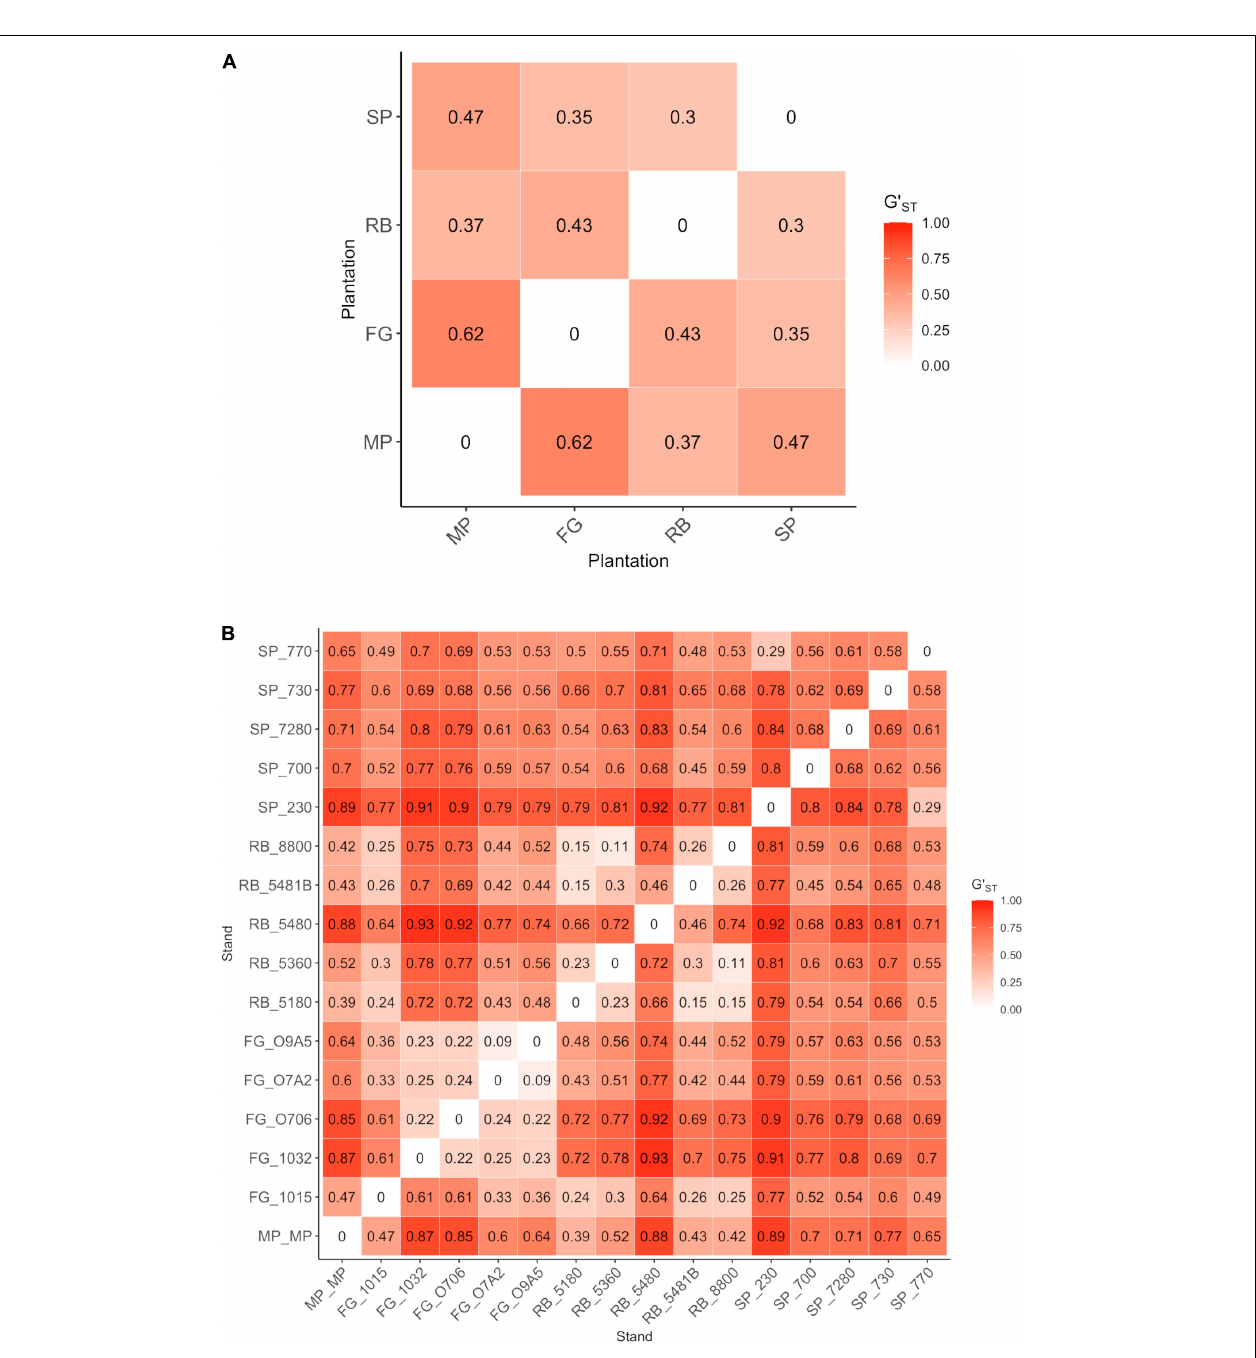
FIGURE 4 | Pairwise genetic differentiation (G’ ST ) values for Leptographium wageneri var. pseudotsugae isolates in (A) plantations, and (B) stands within